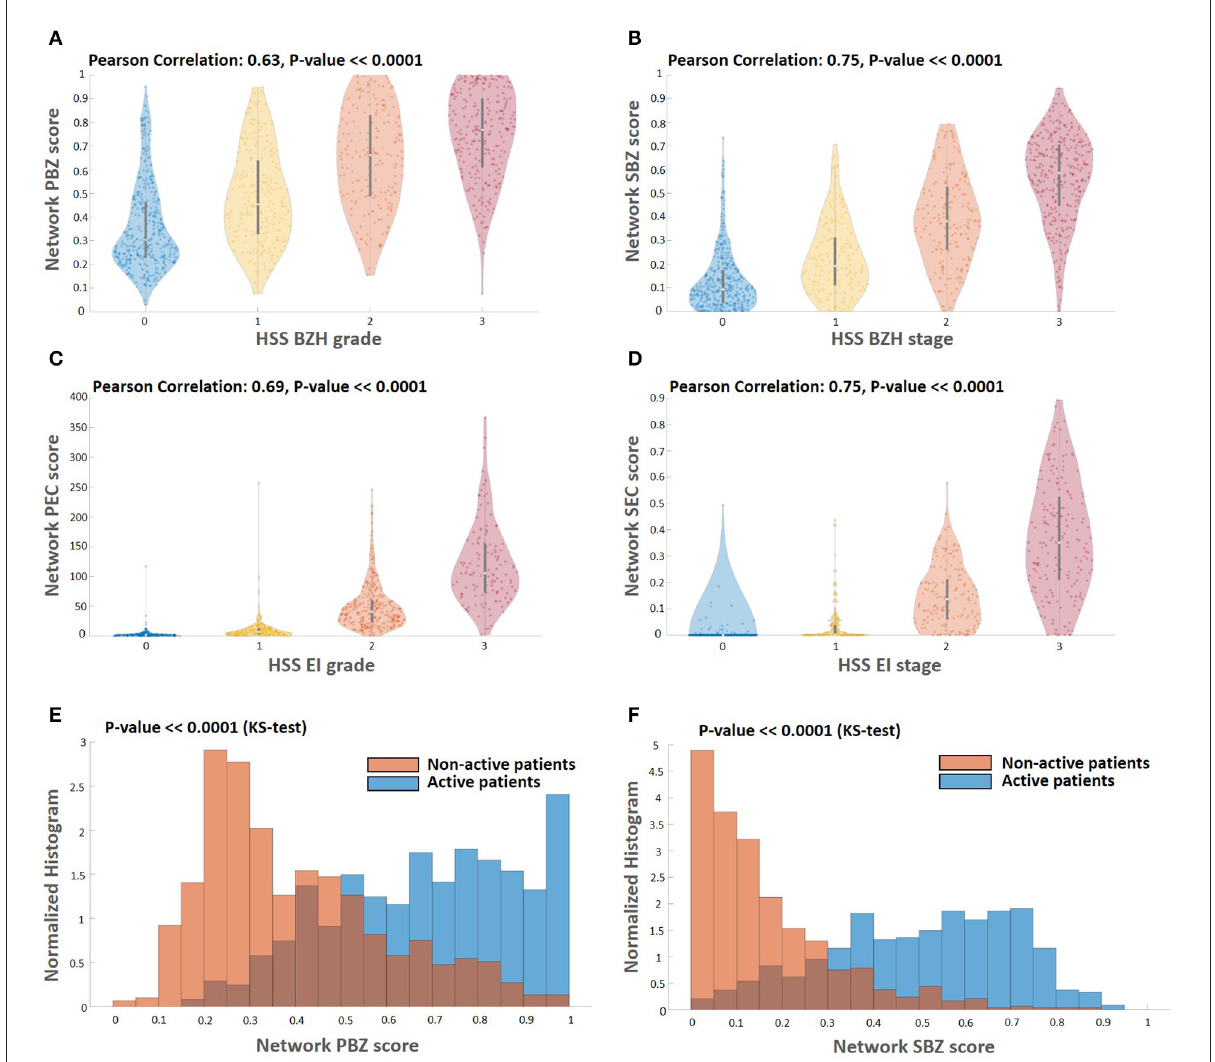
FIGURE4 Correlations among the different score types. (A–D) Comparing the computed scores with the HSS scores. The HSS scoring method for BZH grade, BZH stage, EI grade, and EI stage, each score is an integer between zero and three. Each panel depicts a violin plot that shows the distribution of the computed WSI scores (vertical axis) for each HSS score that is the appropriate proxy (horizontal axis). The white circle indicates the median value, and the black bar indicates the standard deviation. There is a significant correlation between the computed scores and their HSS counterparts. Histograms of basal zone related metrics PBZ (E) and SBZ (F) for active ( PEC ≥ 15) and non-active patients ( PEC < 15). Both the PBZ and SBZ distribution scores of non-active patients have significantly lower values than the PBZ and SBZ distribution scores of the active patients (Kolmogorov–Smirnov-test, P <<